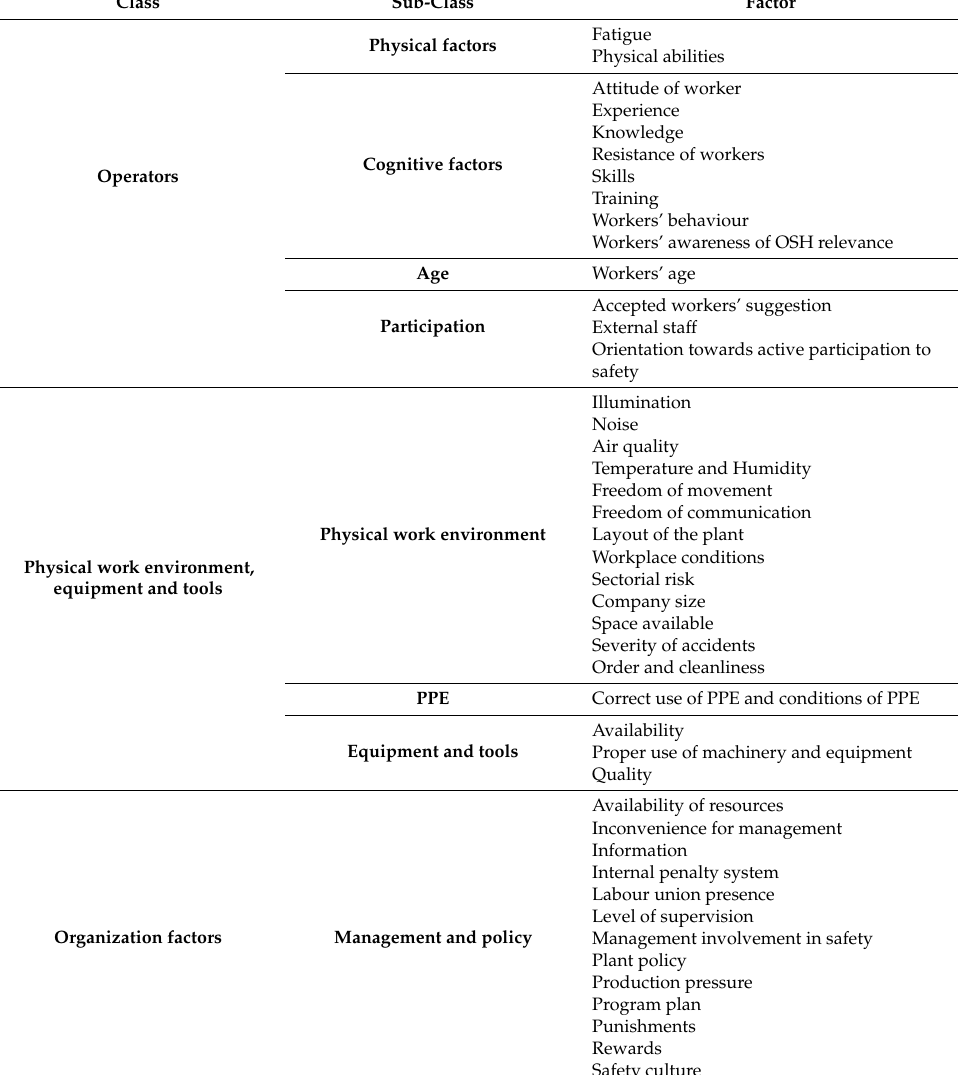
Table 3 schematizes the contextual factors used for the analysis in this research. Table 3. Contextual